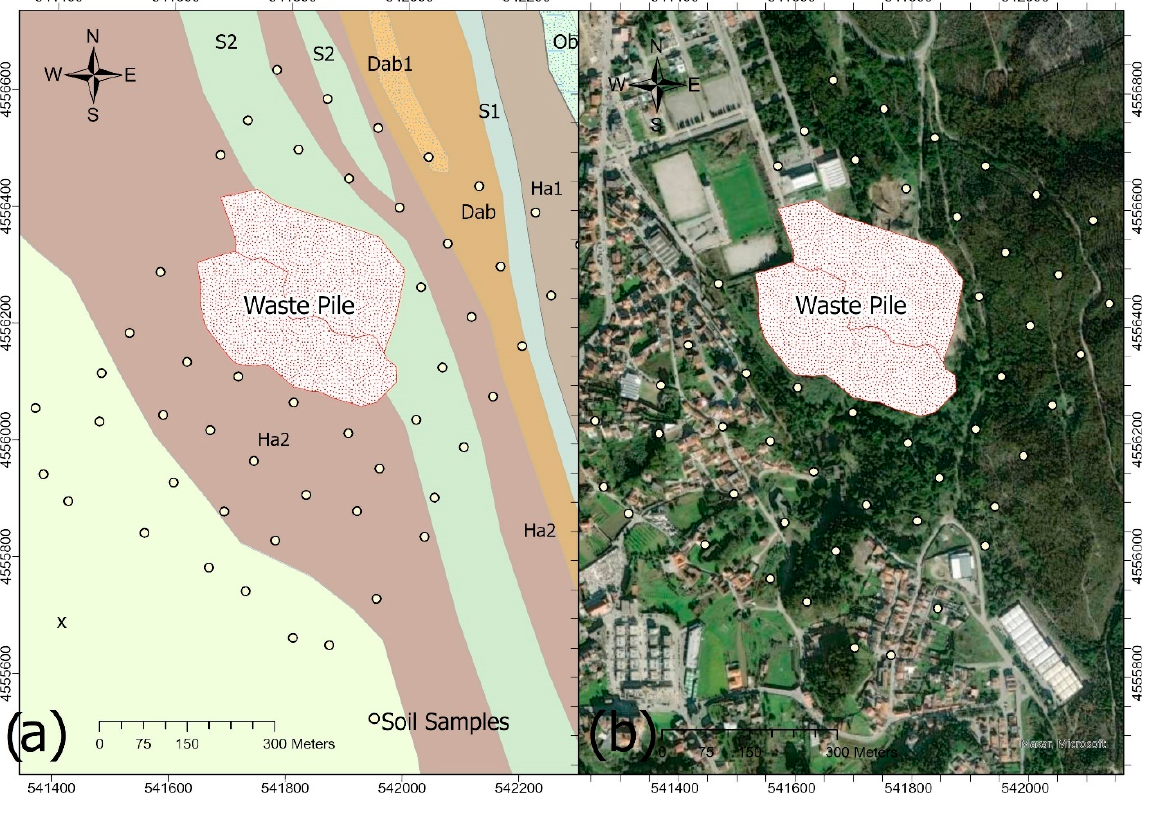
Figure 1. ( a ) Geological setting and sampling points. Legend: X—Precambrian and/or Cambrian schists and greywackes; Ob—Ordovician quartzites with schist intercalations; Ocd—Ordovician shales; S1—Silurian schists; S2—Silurian schists, greywackes, and quartzites; Dab—Devonian shales and sandstones; Dab1—Devonian quartzites; Ha1—Carboniferous conglomerates, sandstones, and micaceous schists; Ha2—Carboniferous conglomerates, arkoses, carbonaceous schists, and anthracite. ( b ) Local setting—proximity to urban and service